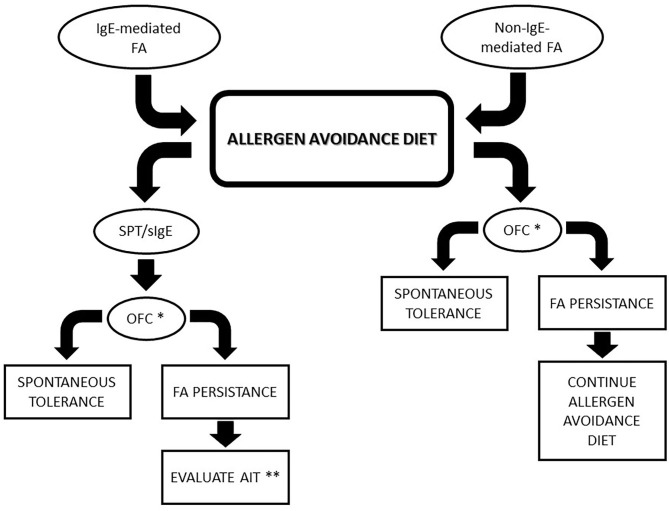
Algorithm for food allergies management. * In case of previous life-threatening reactions, specifically evaluate every patient before considering OFC. ** Consider AIT in children with IgE-mediated FA who did not achieve spontaneous tolerance at 4–5 years of age. FA, Food allergy; AIT, active immunotherapy; OFC, oral food challenge; SPT, skin prick test.